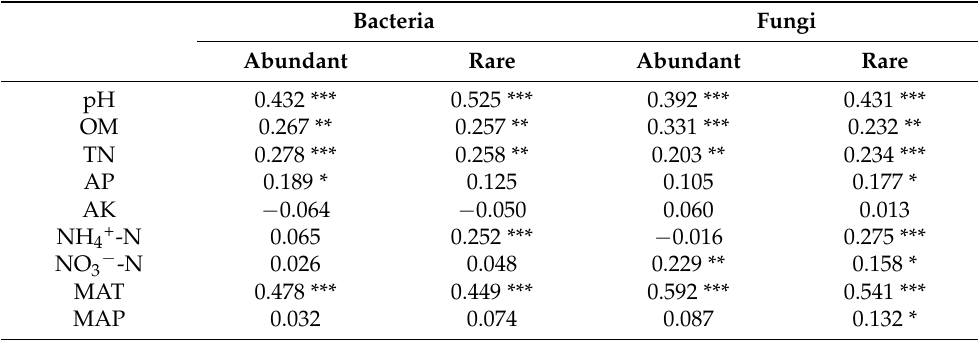
Table 2. Mantel tests based on Spearman’s rank correlations show the relationships between the bacterial and fungal community structures and environmental variables. Bacteria Fungi Abundant Rare